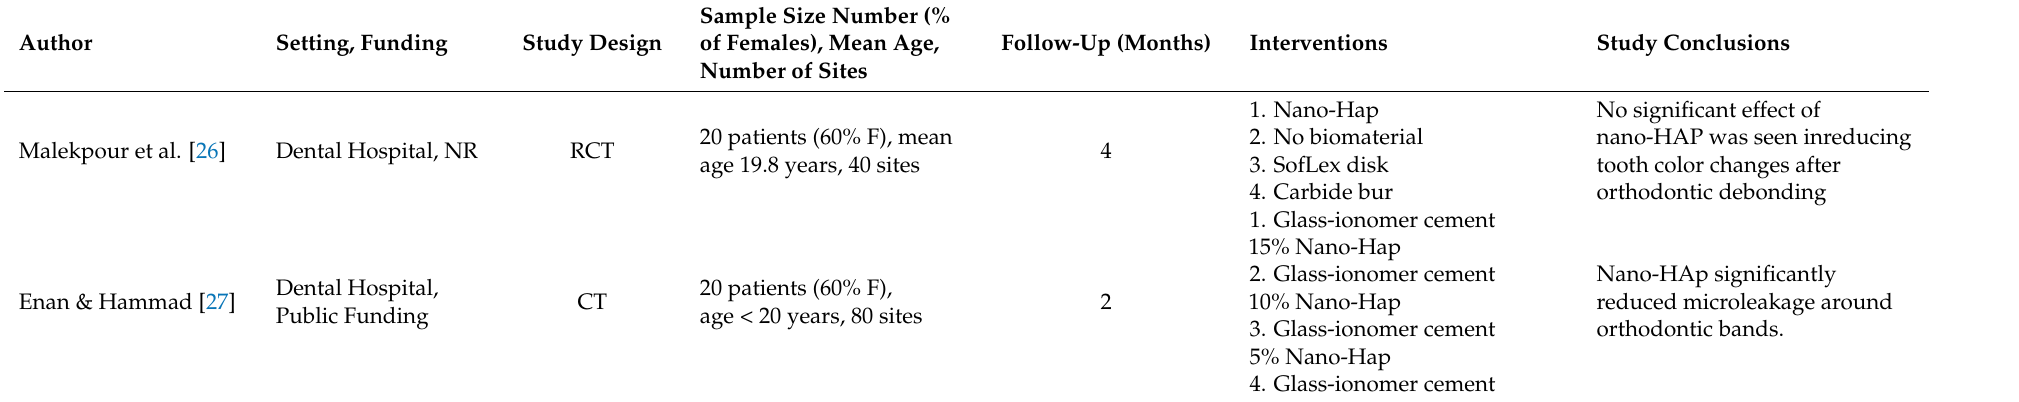
Table 3. Summary of Nano-HAp application in orthodontics.